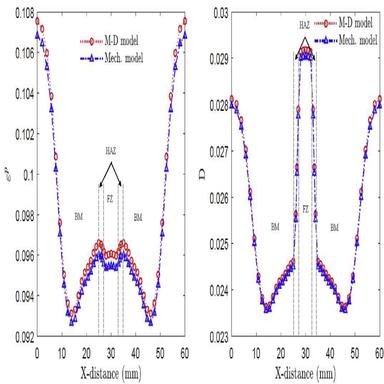
Equivalent plastic strain p (to the left) and damage variable D (to the right): comparison between the mechanical model and the M-D model.